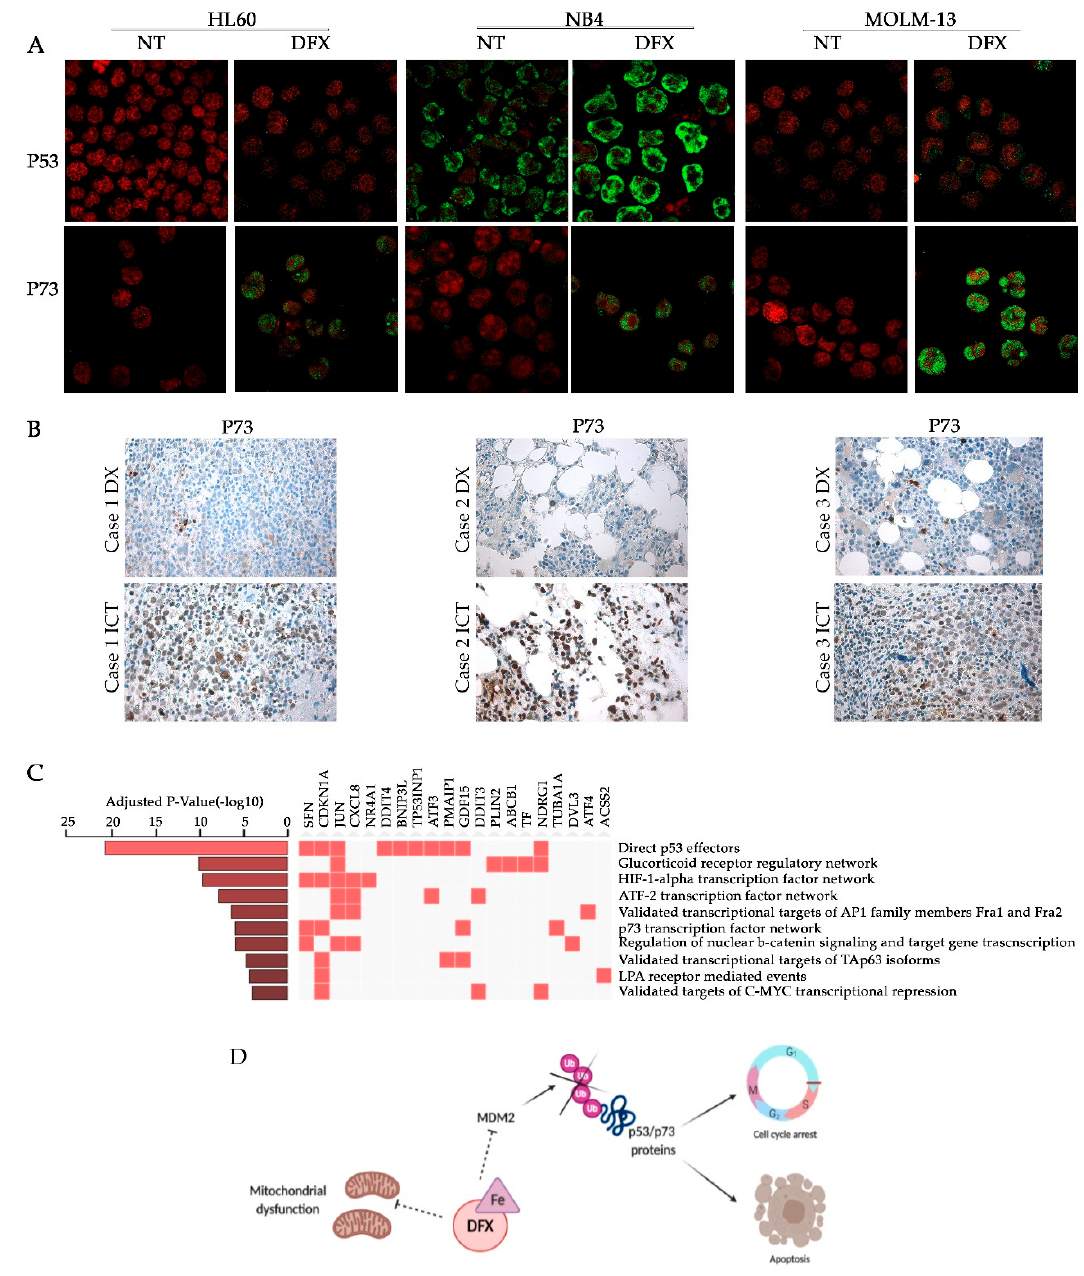
Figure 4. Deferasirox regulates p53 and p73 protein stability. ( A ) Immunofluorescence of p53 and p73 after DFX treatment. The green signal corresponds to p53 or p73 while the red propidium is used to detect nuclei (63 × magnification). ( B ) p73 Immunohistochemistry on MDS bone marrow samples derived from 3 di ff erent patients at diagnosis (DX) and within one year of iron chelation treatment (ICT) (20 × magnification). ( C ) Di ff erentially expressed genes clusters enriched according to Gene Ontology terms and ordered by ascending adjusted p -value. ( D ) Schematic representation of the plausible role of iron chelation on mitochondrial activity and on p53 family stability (created in biorender.com). Abbreviations: NT, not treated; DFX,